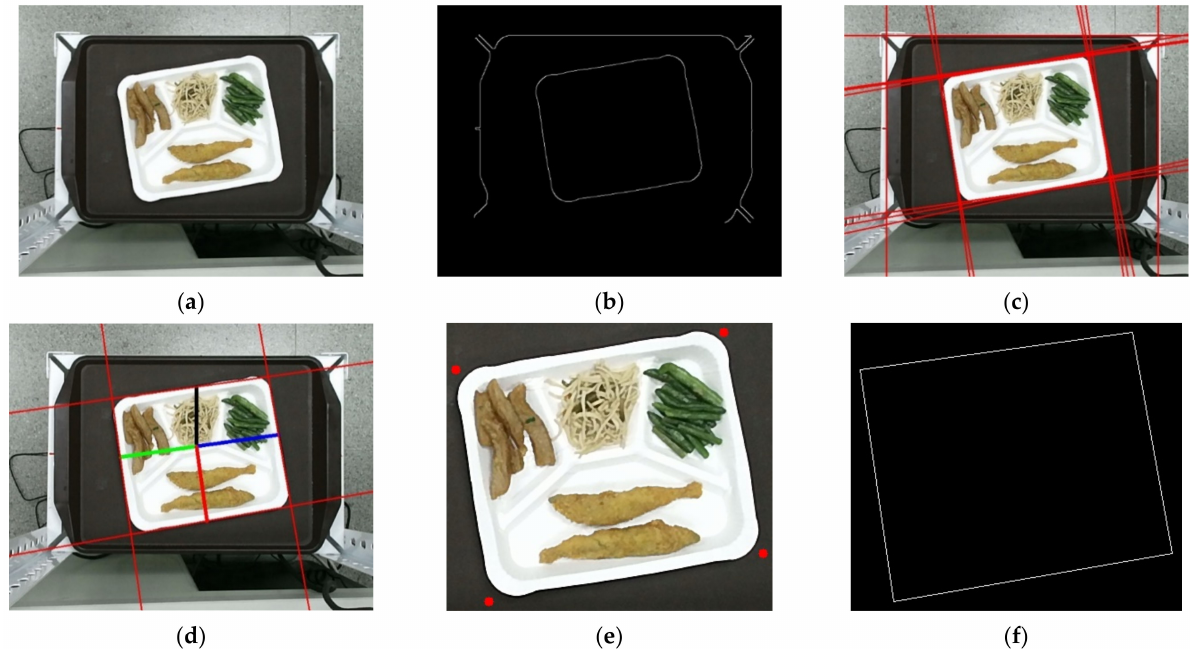
Figure 6. The process of food plate region detection: ( a ) original test image; (b ) edge image; ( c ) detected lines by Hough transformation; ( d ) the closed four line segments surrounding the food plate; ( e ) four corner points; ( f ) the bounding box of the food